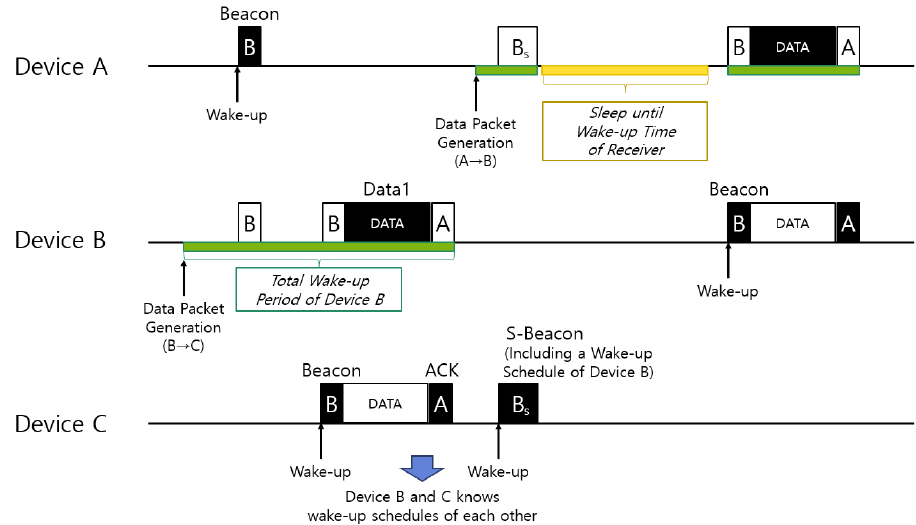
Figure 3. Proposed NA based duty cycling.